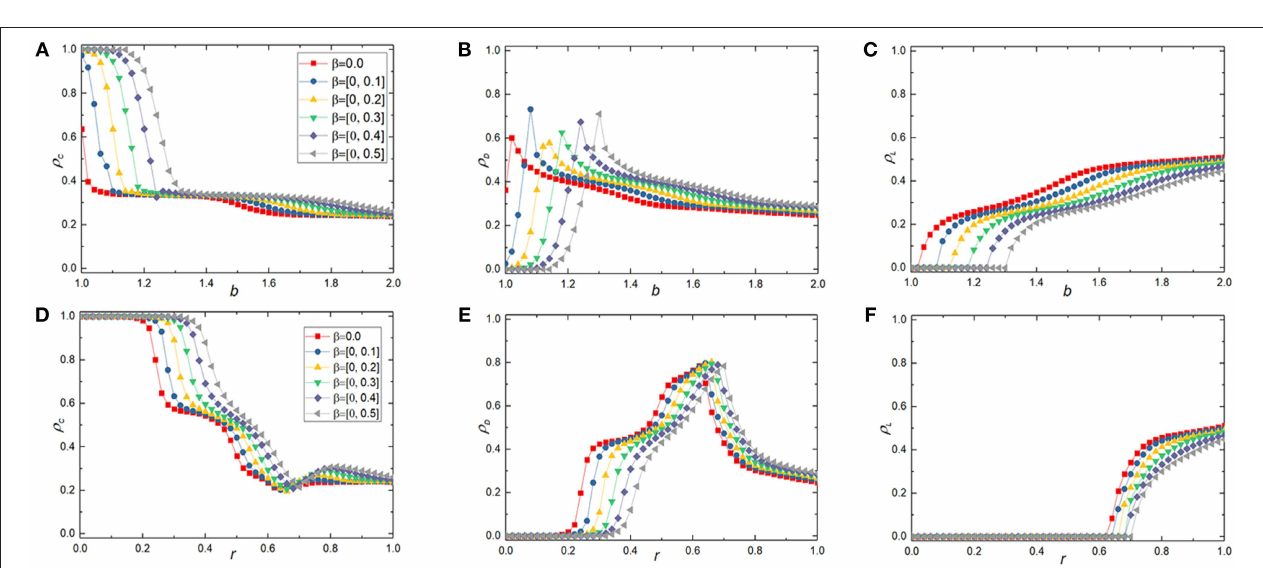
FIGURE 2 | Average frequency of cooperators( ρ C ), defectors( ρ D ), loners( ρ L ) at the stationary sate in dependence on b in the voluntary PDG or r in the voluntary SDG at different random reciprocal rewarding strength [0, β ] on square lattice. In the top panels [from (A–C) ], the simulation results are acquired in the voluntary PDG, while for the bottom panels [from (D–F) ], results are acquired in voluntary SDG. In all simulations, other parameters are set to be L = 100, MCS = 5 × 10 4 , σ = 0.3, K =